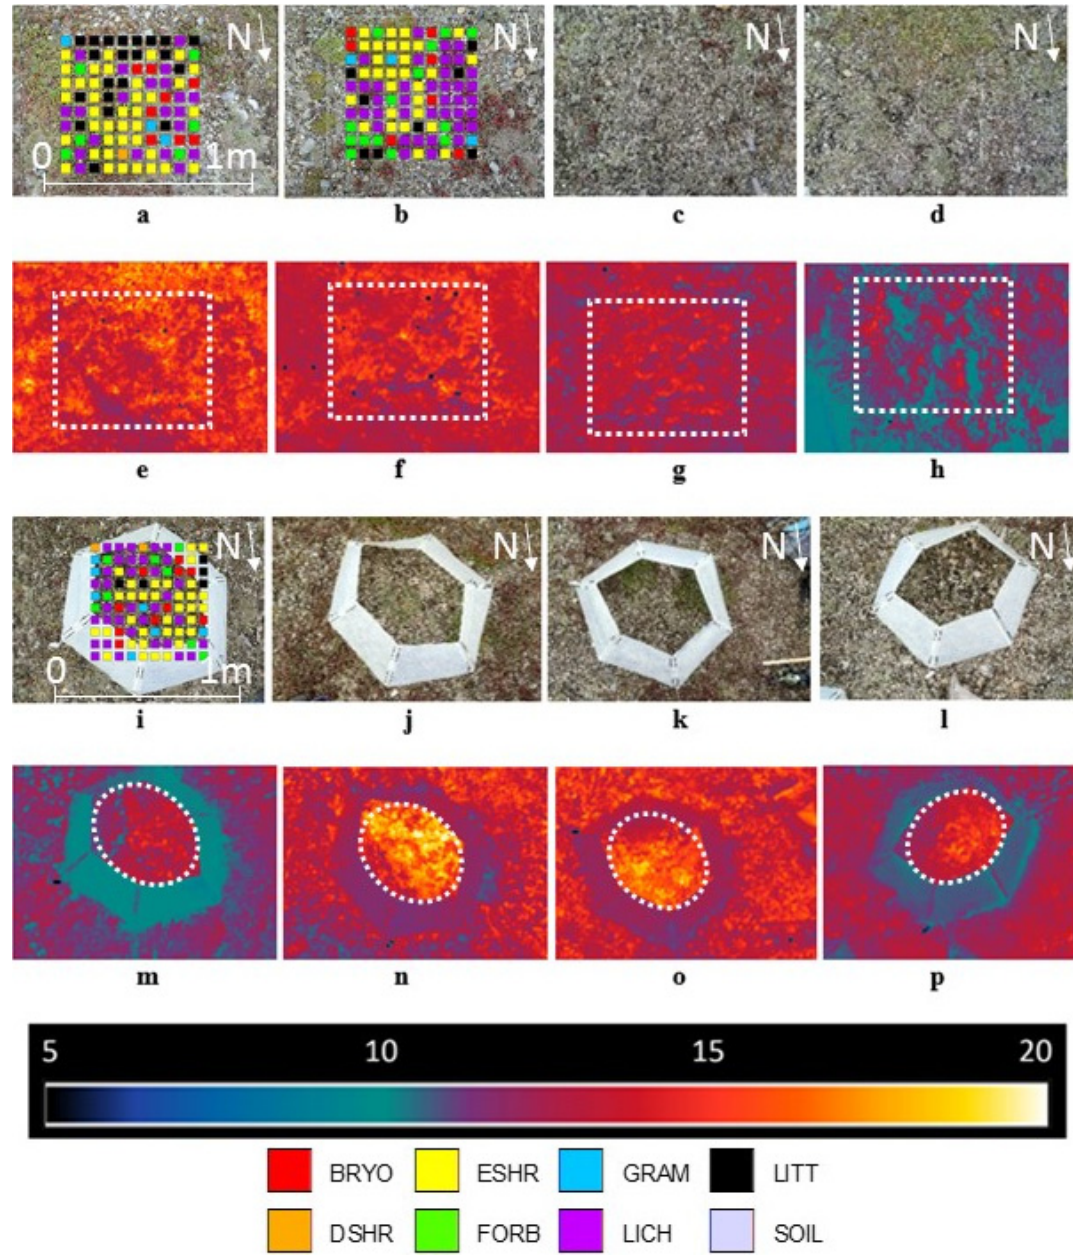
Figure 7. Images depicting four Toolik Lake dry site plots ( a – d ) and the coinciding thermal images below ( e – h ); and images of four additional plots ( i – l ) with coinciding thermal images below ( m – p ). Areas of image analysis are outlined with dotted white lines. All temperatures are in degrees Celsius. Plant growth forms and surface features are depicted with the following abbreviations—BRYO: bryophyte/moss; DSHR: deciduous shrub; ESHR: evergreen shrub; FORB: forb; GRAM: graminoid; LICH: lichen; LITT: leaf litter; SOIL: bare soil/rock. Note: cover data were not available for all plots.